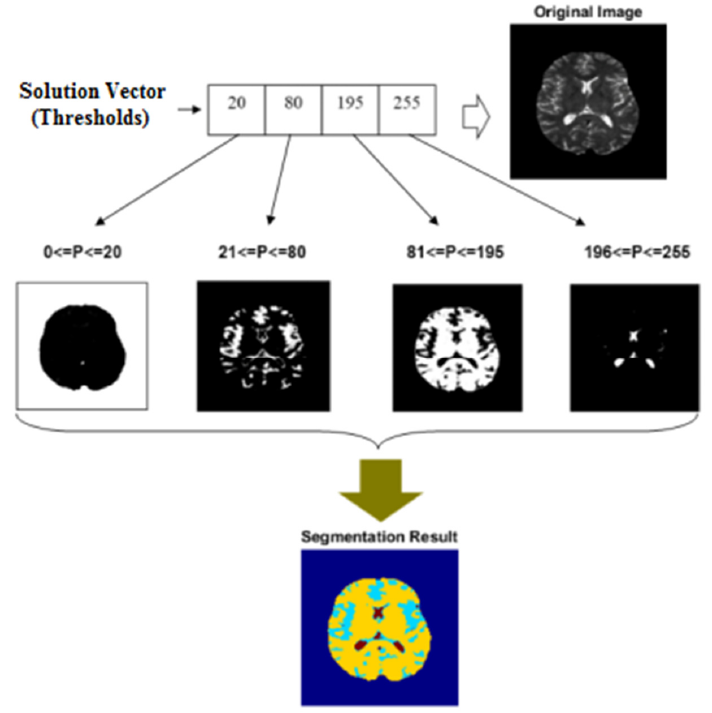
Figure 2. The structure of a solution vector in SSO algorithm for MRI segmentation .